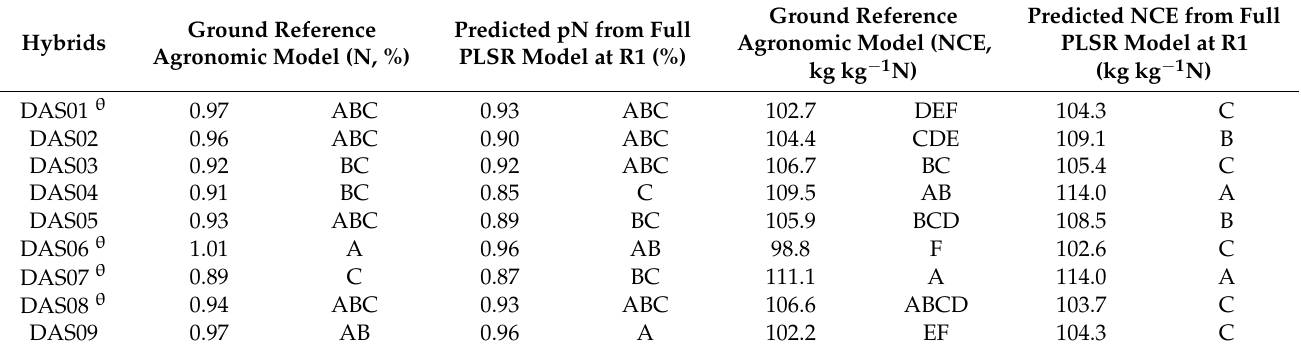
Table 3. Comparison of hybrid differentiation results for ground reference models and Full PLSR models based on R1 image for predicting N concentration (pN, %) or NCE at R6 (NCE, kg kg − 1 N). Tukey–Kramer least square means and letter differences shown. Means with the same letter are not different. Hybrids marked to indicate whether hybrids tested across two ( θ ) or three site